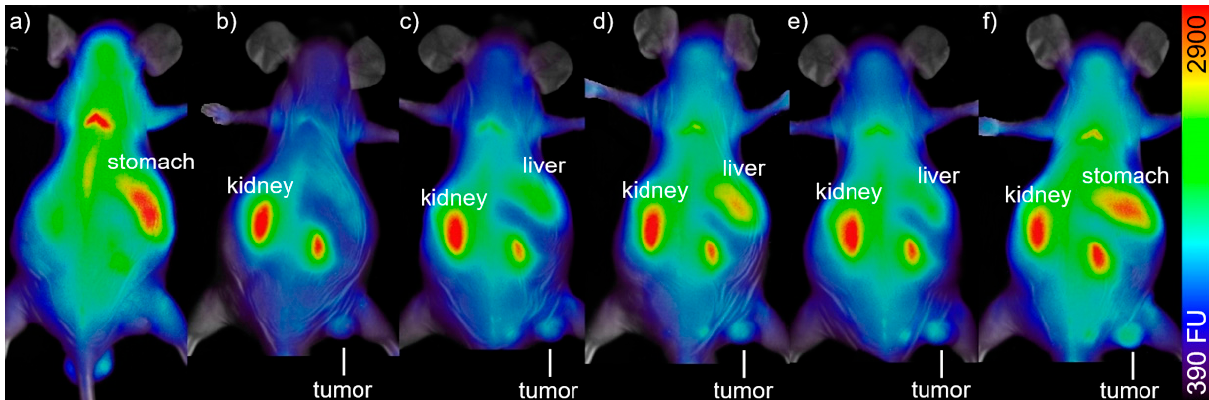
Figure 6. In vivo biodistribution of 50 μ g/100 μ L AuNPs 8 in a A431-tumorbearing mouse: ( a ) fluorescence before injection, ( b ) 4 h p.i., ( c ) 21 h p.i., ( d ) 28 h p.i., ( e ) 48 h p.i., and ( f ) 72 h p.i. Ratio tumor:muscle:liver:kidney/g = 4.4:1.0:0.6:5.4 ( e ).